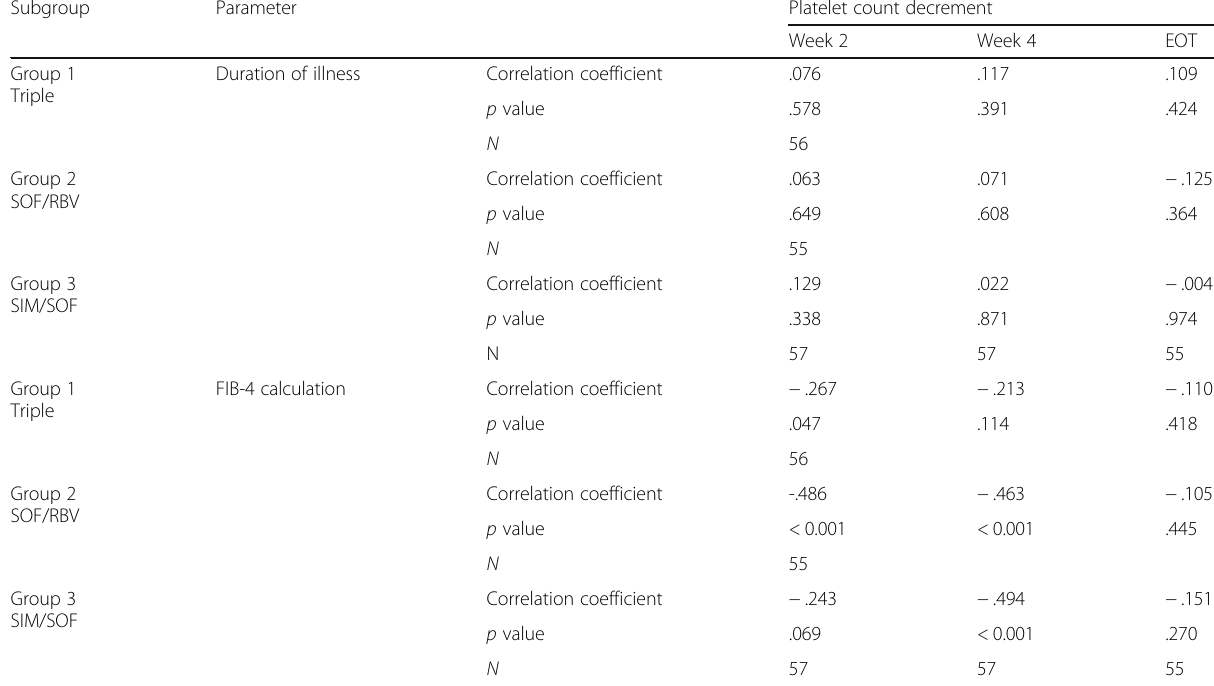
Week 2 Week 4 EOT